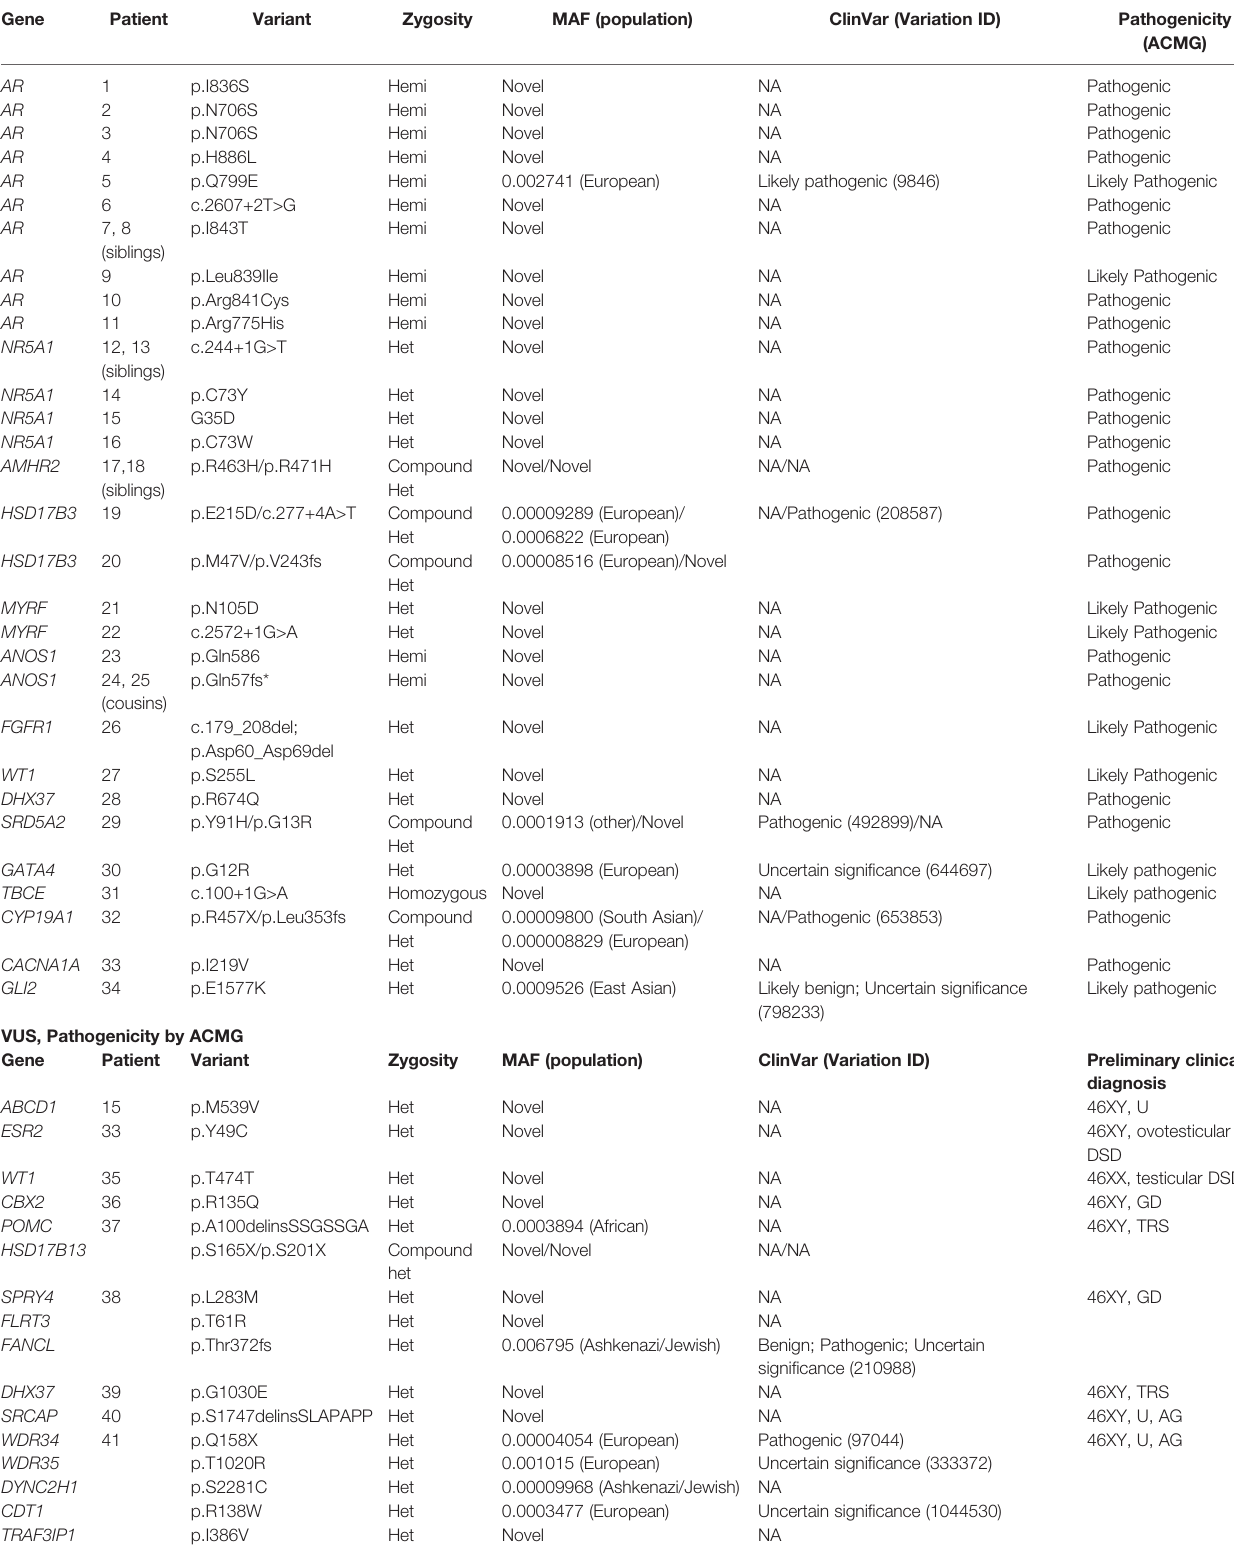
TABLE 2 | Genetic causes of DSD in patients from the Ukraine DSD Register. Gene